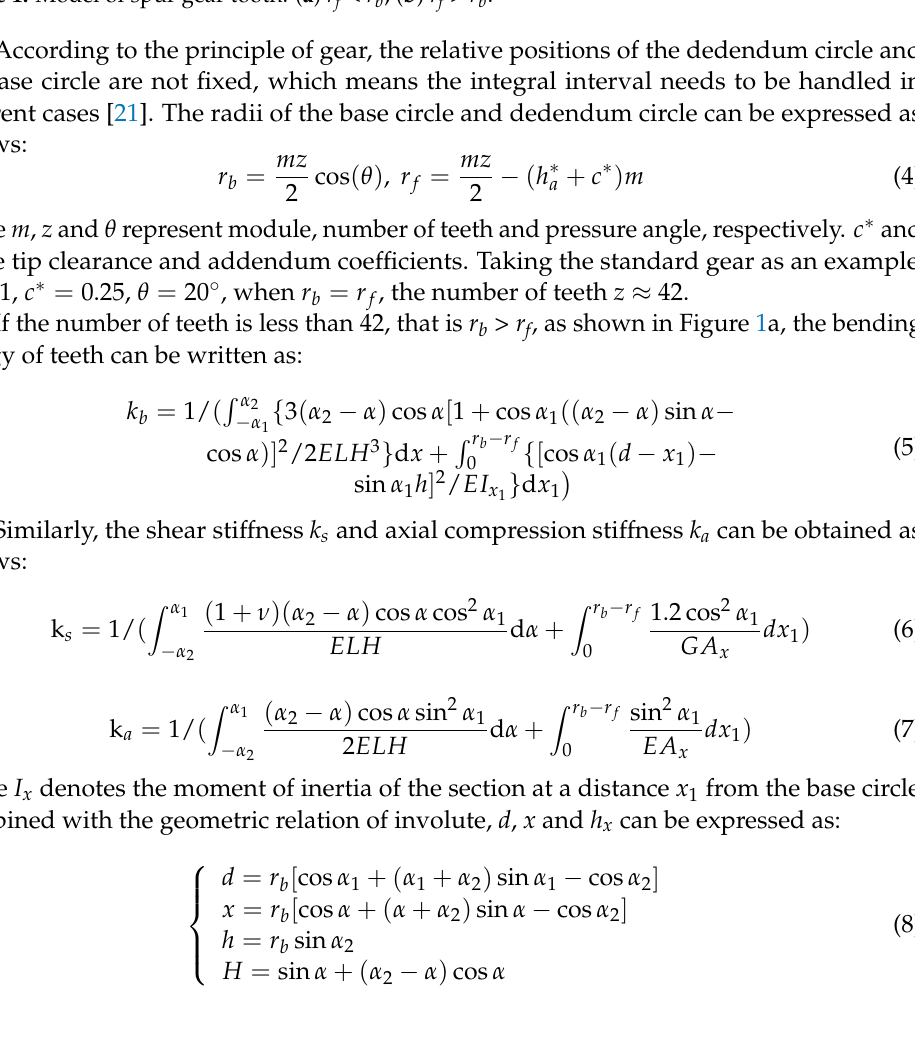
Figure 1. Model of spur gear tooth: ( a ) r f < r b ; ( b ) r f > r b